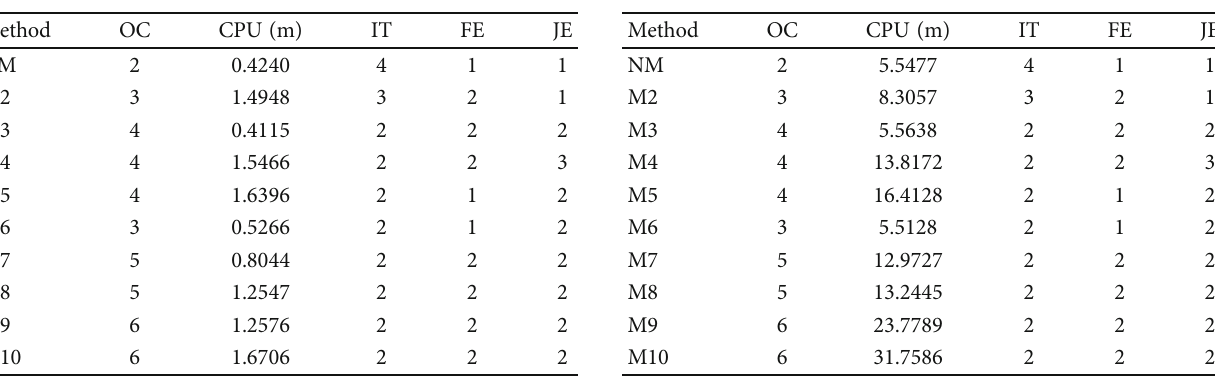
Figure 2: Values of FJC1 (a) and FJC2 (b) to solve Test Problem 1 for FJM8-FJM11 as a function of n . Table 13: Parameters of methods 1-10 to solve Test Problem 5, by Table 14: Parameters of methods 1-10 to solve Test Problem 5, by the algorithms of the fi rst category for n = 100 . the algorithms of the fi rst category for n = 250 .